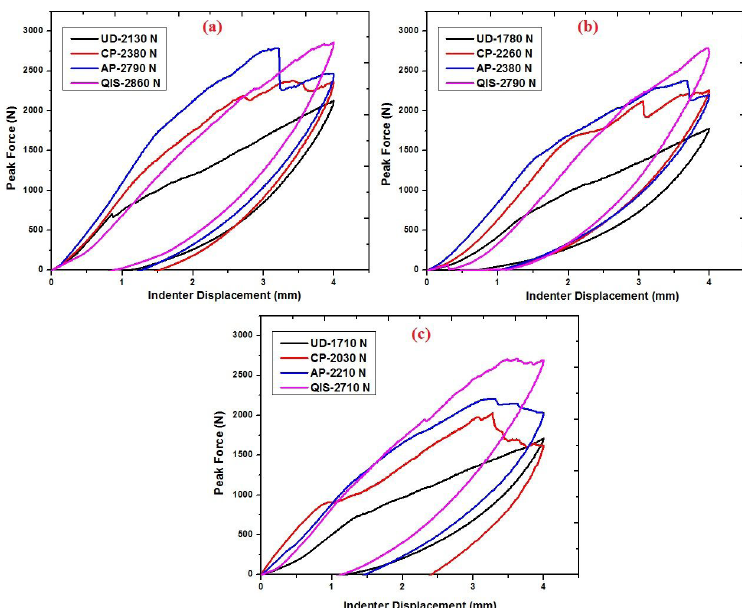
Figure 3. Indentation displacement Vs Peak force under different indentation loading planes (a) 0 o , (b) 10 o and (c) 20 o